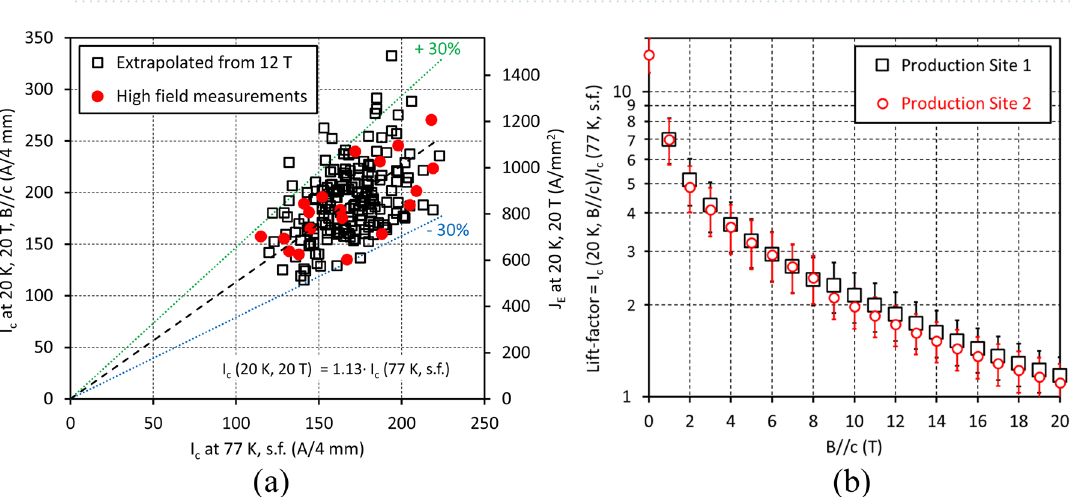
Figure 4. Statistical data for the new YBCO wire at 20 K in magnetic field ( B//c ). ( a ) Correlation between I c at 77 K in self-field and I c at 20 K, 20 T. Linear approximation starting at origin gives the slope (lift-factor)